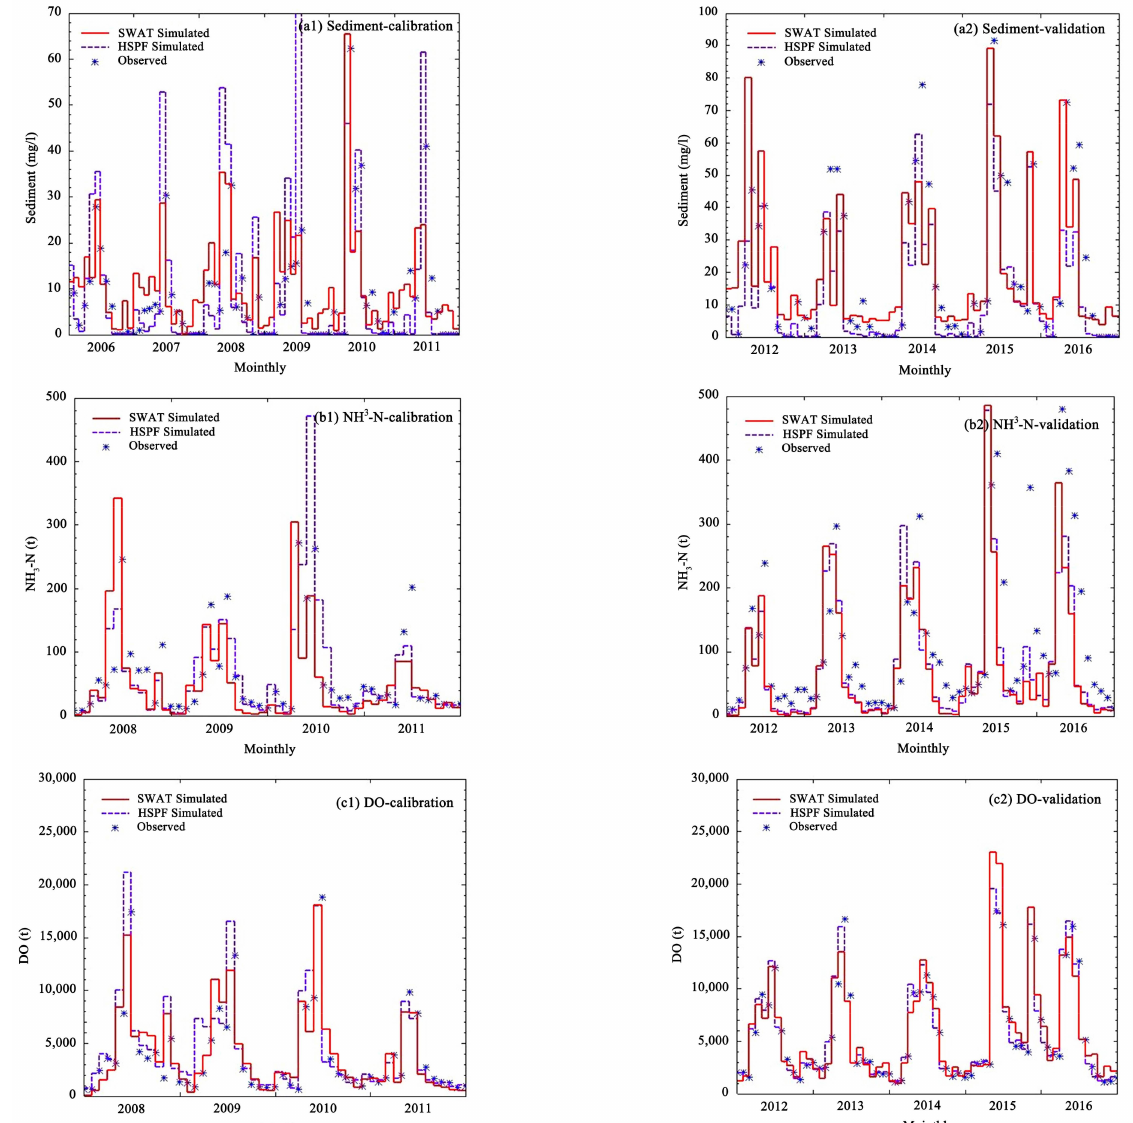
Figure 4. Comparison of the simulation results of two models: ( a1 , a2 ) sediment; ( b1 , b2 ) NH 3 -N; ( c1 , c2 ) DO (calibration period: left; verification period: